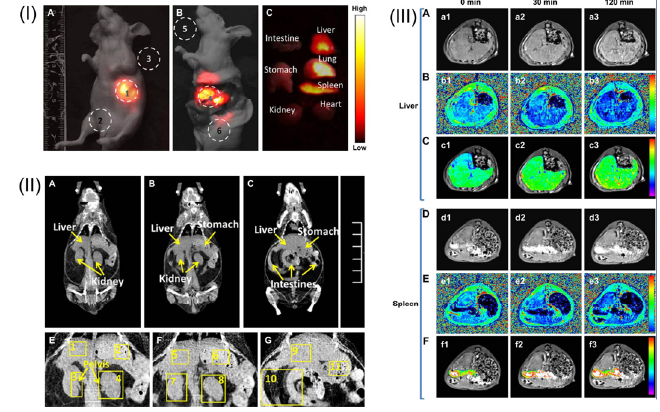
Figure 11. ( I ) A whole-body imaging of UCNPs@SiO -GdDTPA 2 (Diethylenetriaminepentaacetic Acid) for 10 min. ( I-A ) In vivo imaging of the sacrificed -GdDTPA for 10 min. ( I-B ) Ex vivo nude mouse after injection with UCNPs@SiO 2 imaging of nude mouse. ( I-C ) Ex vivo imaging of viscera. All images were acquired under the same instrumental conditions, and the power density of the 980 nm laser is 150 mW cm − 2 . ( II ) The application of in vivo CT imaging in Kunming mice. ( II-A , B and C ) serials coronal CT images of Kunming mouse at different layer after injection with -GdDTPA. ( II-E , F and G ) partial enlarged CT view of abdomen. ( III ) The UCNPs@SiO 2 application of in vivo MRI imaging of the Kunming mice. ( III-A ) T -weighted MR images 1 of liver after injection with UCNPs@SiO -GdDTPA for 0, 30 and 120 min ( III-B ) T 2 1 -GdDTPA for 0, 30 and distribution images of liver after injection with UCNPs@SiO 2 120 min. ( III-C ) Local colorized T -weighted MR images of liver after injection with 1 -GdDTPA for 0, 30 and 120 min. ( III-D ) T -weighted MR images of spleen UCNPs@SiO 2 1 after injection with UCNPs@SiO -GdDTPA for 0, 30 and 120 min. ( III-E ) T distribution 2 1 images of spleen after injection with UCNPs @ SiO -GdDTPA for 0, 30 and 120 min. 2 -weighted MR images of spleen after injection with ( III-F ) Local colorized T 1 UCNPs@SiO -GdDTPA for 0, 30 and 120 min. Adapted with permission from reference [85]. 2 Copyright: Elsevier,